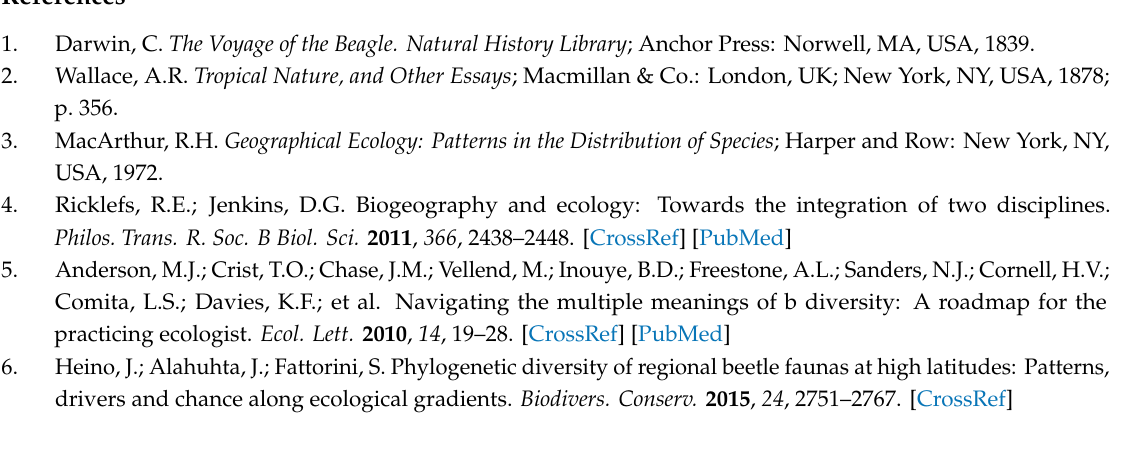
Table S1: Environmental data of lakes extracted from the literature and considered in the analyses. Figure S1: Partial dependence plots showing the responses of fish (left) and macrophyte richness (right) to each